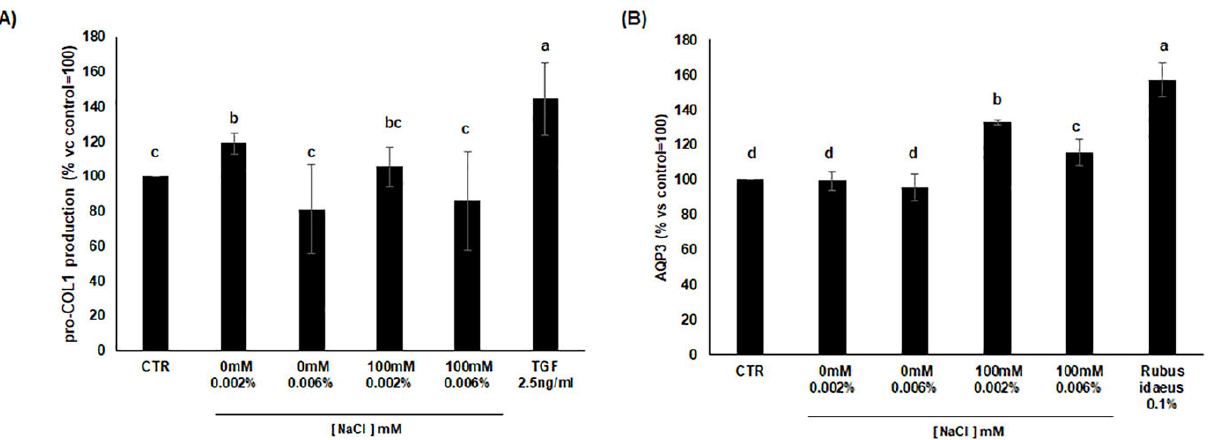
Figure 6. Effects of cardoon calli extracts on increasing the production of ( A ) pro-collagen I compared to TGF β treatment and ( B ) AQP3 protein in comparison with Rubus idaeus as positive control; the quantization was performed by detection with antibody labeled with fluorophore. The bars represent the mean of three biological replicates ± SD. Statistical significance was determined between treatments within each time point by using one-way ANOVA with Tukey’s post hoc test. Different letters indicate significant difference ( p -value < 0.05). CTR, control unstressed cells; 0 mM and 100 mM NaCl, saline stress treatment.